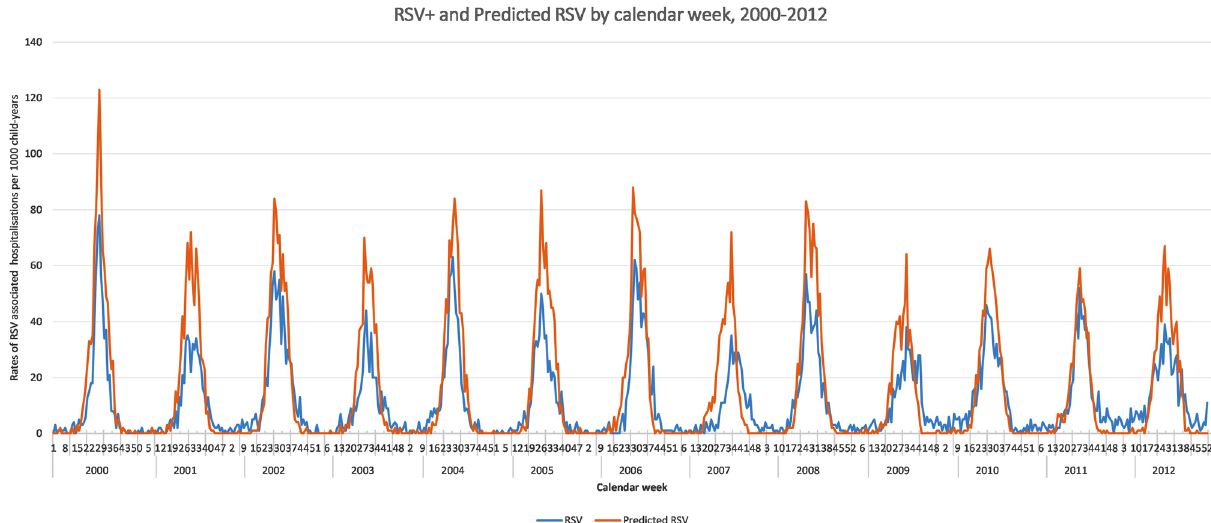
Figure 3. Laboratory- confirmed hospitalised RSV positive and predicted RSV cases by calendar week for children < 2 years,